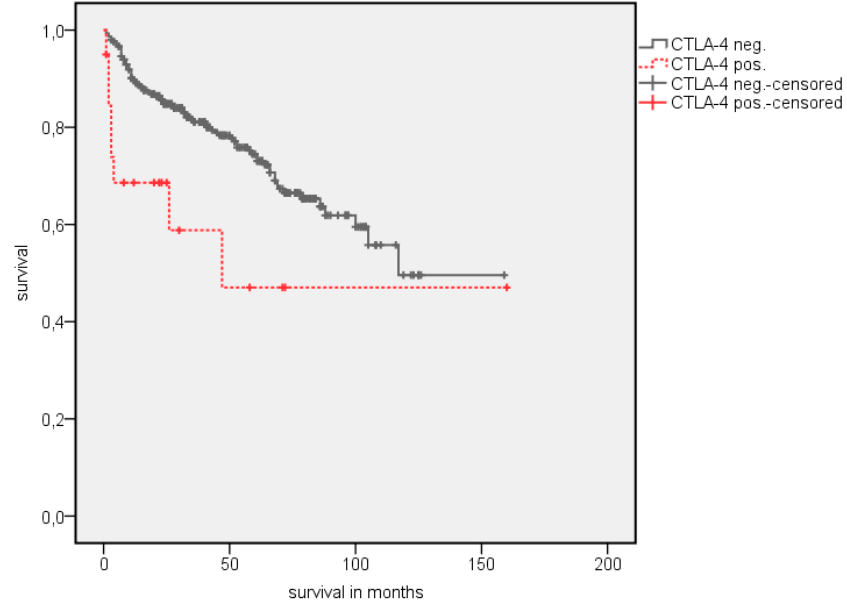
Figure 4. Kaplan Meier analysis: Association of CTLA-4 expression in TIMC with OS in all RCC patients.